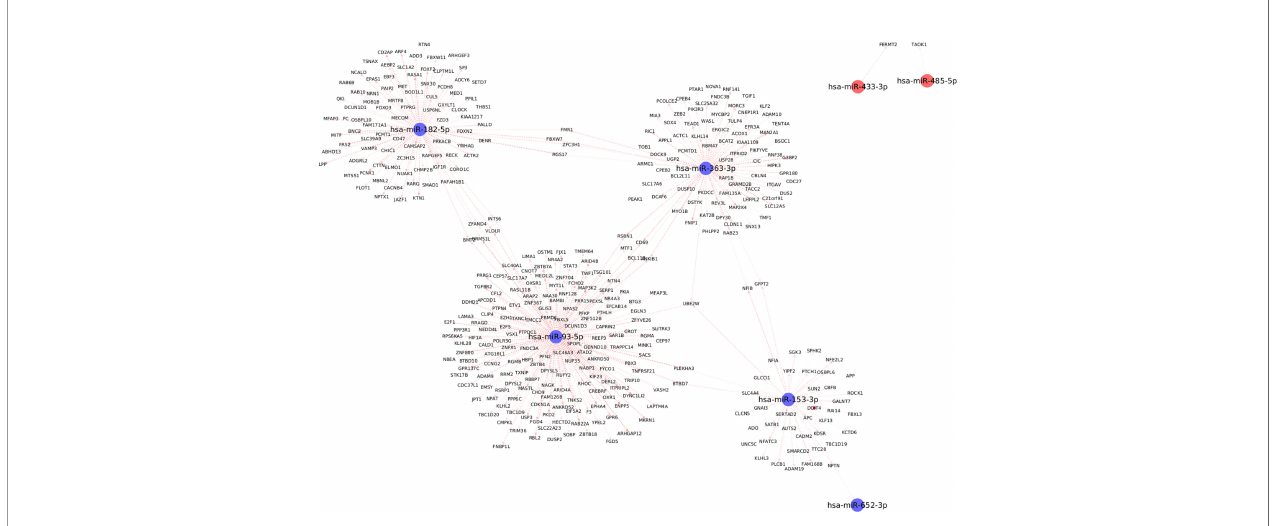
FIGURE 5 | Top differentially expressed miRNAs with strong known interaction (coming from >=10 resources and interaction score>=0.75 from mirDIP) with target genes. Here we highlight only those miRNAs which are signi fi cantly correlated with at least one clinical trait relevant to metabolic